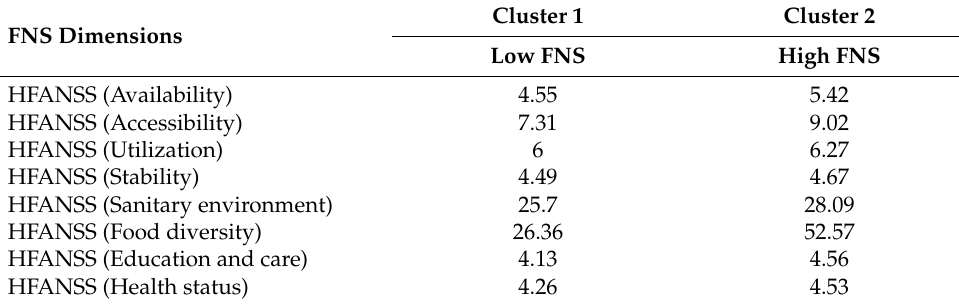
Table 1. Results of the cluster